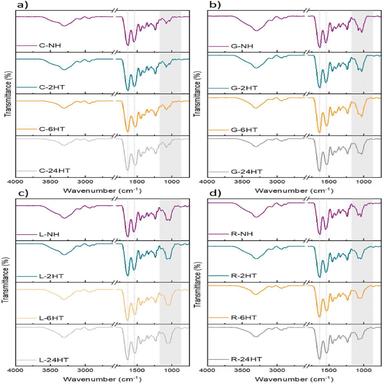
FTIR spectra of fish gelatin-based films as a function of saccharide: b) glucose (G); c) lactose (L); and d) ribose (R), and heating time (non-heated (NH), heattreated (HT) at 2, 6 and 24 h). Films with no saccharide were used as control (C, a)).